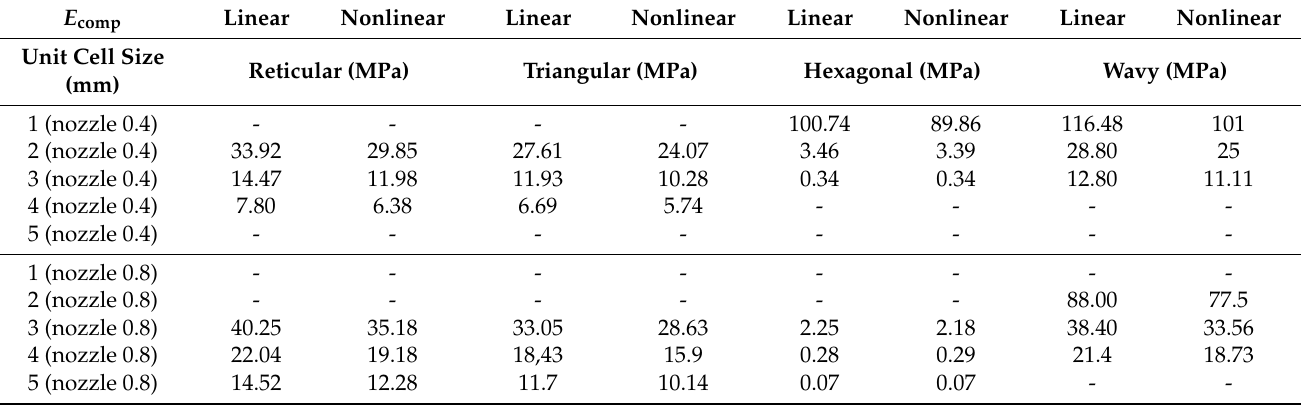
Table 2. Compressive elastic moduli from the linear model in comparison with the Van der Waals nonlinear hyperelastic